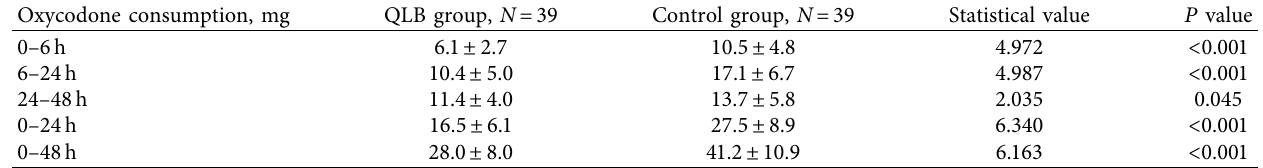
Table 3: Cumulative oxycodone consumption at 48h after surgery.